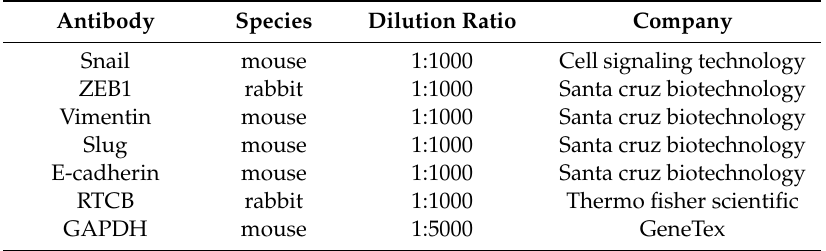
Table 2. List of primary antibodies used for Western Blot in this